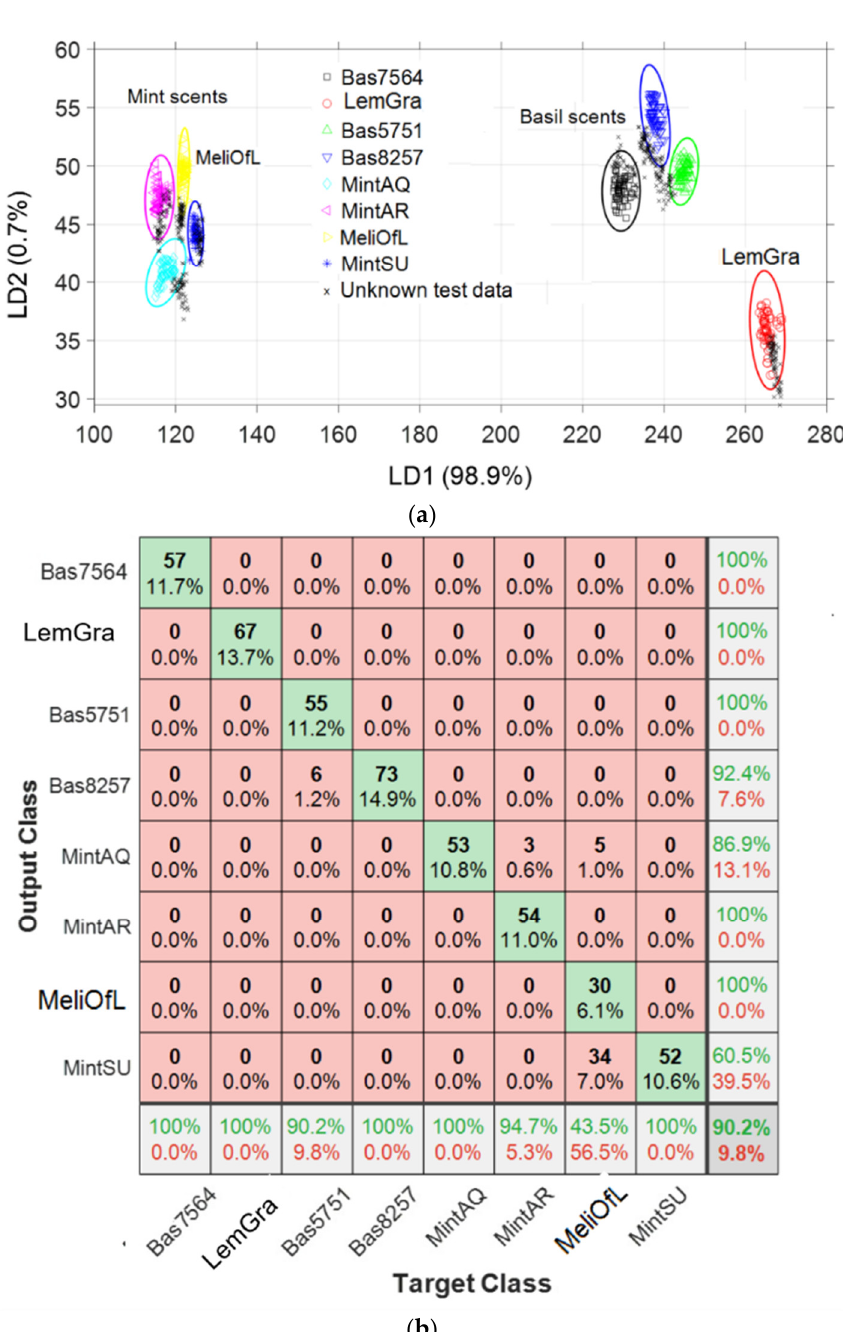
Figure 8. Linear discriminant analysis of six mint species: ( a ) 2D plot of the 10-fold linear discriminant analysis obtained from the training data sets shown with the colored symbols (first-cycle e-Nose measurements) and from the prediction data sets shown with the black symbols (second cycle of the e-Nose measurements), and ( b ) a prediction confusion matrix for the unknown data sets from the second cycle of the e-Nose measurements.